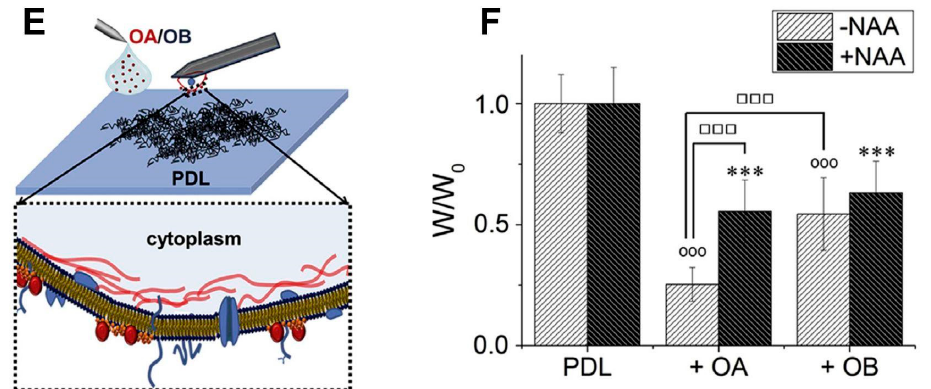
Figure 7. ( A ) Schematic representation of the experimental setup with OA, OB, FA, and PFB aggre- gates on different regions of the functionalized glass substrate. ( B ) Cartoon of the four steps of the experiment. First, the cell was in contact with the functionalized substrate under a defined force (I); then, the AFM cantilever moved away from the substrate until the maximal adhesion force was reached. At this time, no adhesion interactions have been broken and the cantilever was applying a traction force on the cell (II). The cell was then gradually detached from the substrate; the detach- ment process was characterized by several rupture events, corresponding to jumps of the traction force (III). A final plateau at a force of 0 nN was reached when the cell was fully detached (IV). ( C ) Typical F–D curve acquired using SCFS with the four steps described in ( B ). The detachment work (W), represented by the gray area below the baseline at a force of 0 nN, quantifies the interaction between the cell and the substrate. ( D ) Mean work spent to detach the cell from the substrate (W) for the various aggregate types and obtained from cells treated and not treated with NAA. Error bars correspond to standard deviations. * and *** indicate p ≤ 0.05 and p ≤ 0.001, respectively, relative to CTR. °°° indicates p ≤ 0.001 relative to CTR in the experiments on cells not treated with NAA. ☐☐☐ indicates p ≤ 0.001 in the indicated comparisons. ( E ) Schematic representation of the SCFS experi- ment to test CHO cell adhesion on PDL in the absence and presence of OA or OB. ( F ) Mean work spent to detach the cell from PDL-coated substrates obtained in the absence (PDL) and in the pres- ence of OA/OB (+OA/+OB). Results obtained from NAA-treated cells are represented by the black bars. All the results are normalized to the corresponding value obtained in the absence of protein aggregates, here indicated as W0. Error bars correspond to standard deviations. *** and °°° indicate p ≤ 0.001 relative to PDL. ☐☐☐ indicates p ≤ 0.001 in the indicated comparisons. Reproduced Re- printed with permission from Ref. [111]. 2018, Biophysical Journal.